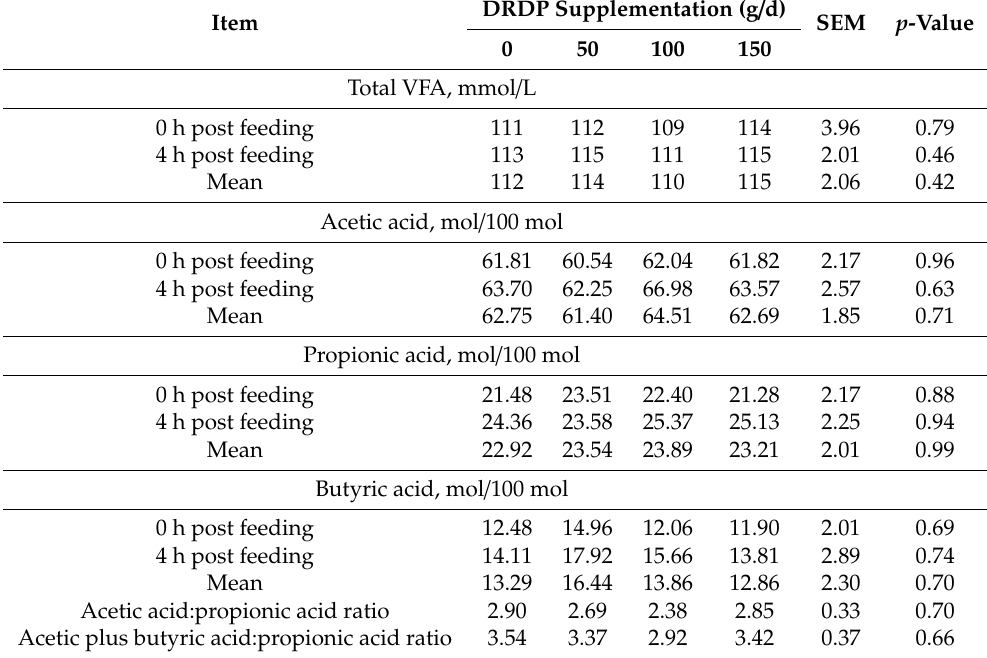
Table 4. Concentrations of total volatile fatty acids (TVFAs) and VFA profiles of Thai native, Wagyu-crossbred beef cattle fed with various levels of dried rumen digesta pellets